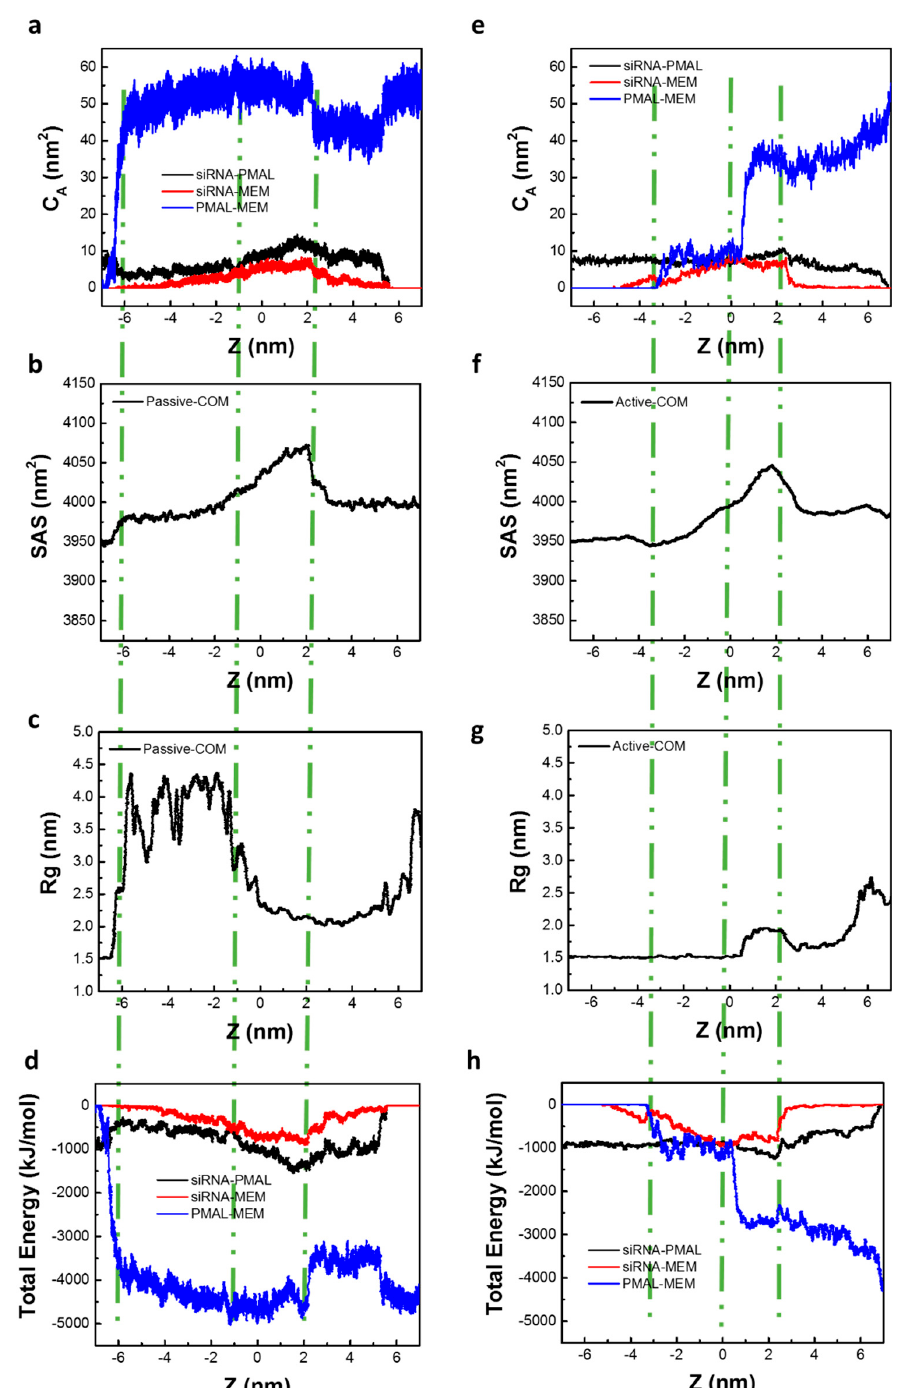
Figure 4. The active and passive transmembrane of siRNA assisted by PMAL where Z represents the distance between the mass center of siRNA and the center of lipid bilayer membrane along the Z direction as shown in Figure 9e. Three green lines from left to right in each figure give the position of siRNA entering, in the center, and leaving the lipid bilayer membrane. ( a , e ) The changes of contact area between siRNA and PMAL, siRNA and membrane, as well as PMAL and membrane in the passive and active transport, respectively; ( b , f ) The change of solvent accessible surface area of lipid bilayer membrane in the passive and active transport, respectively; ( c , g ) the changes of radius of gyrate of PMAL in the passive and active transport, respectively; ( d , h ) the changes of total interaction energies among siRNA, PMAL, and membrane in the passive and active transport, respectively.